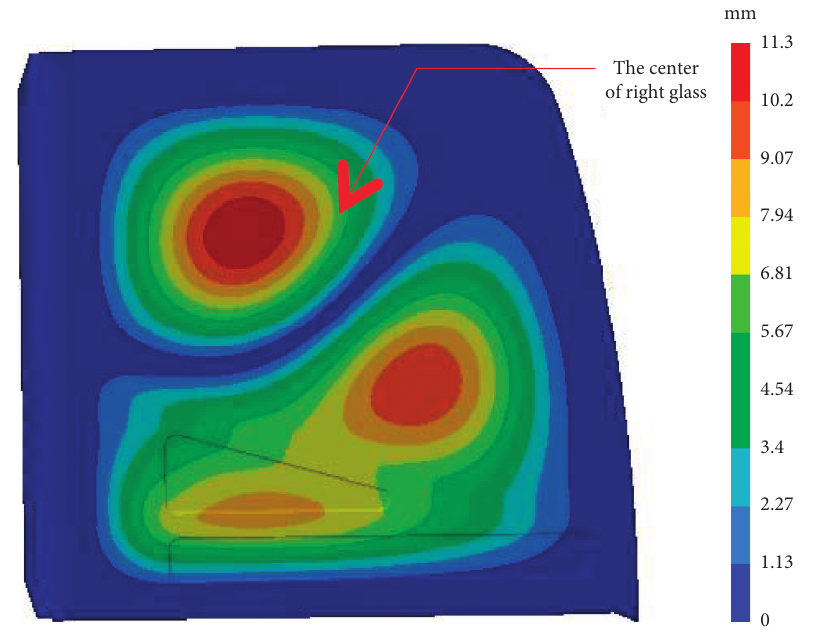
Figure 16: Fourth-order vibroacoustic coupling modal.